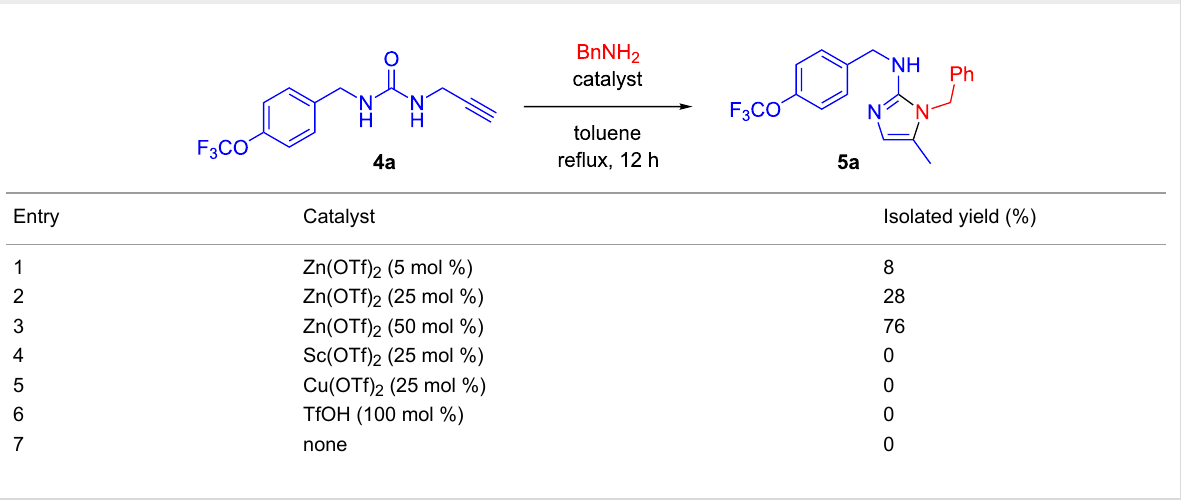
Table 1: Catalyst screening results for the conversion of 4a to 5a .